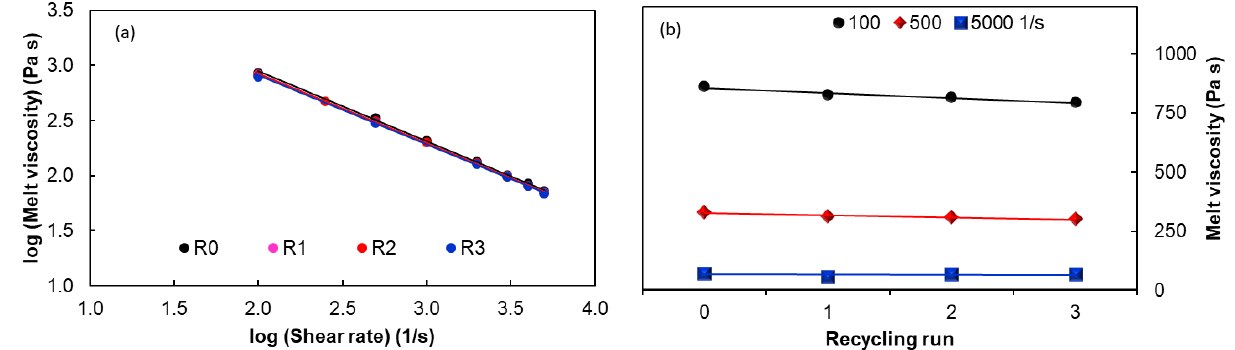
Figure 8. Melt viscosity vs. ( a ) shear rate and ( b ) recycling run of the EVA/MWCNT nanocomposite with 5 wt.% (160 °C).